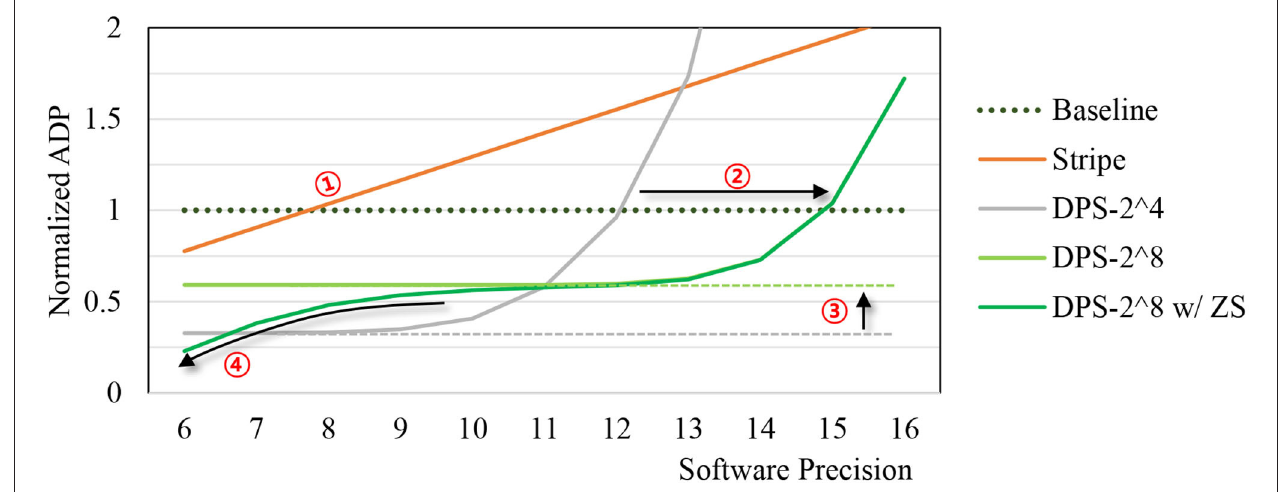
FIGURE 7 | Area-delay product (ADP) vs. software